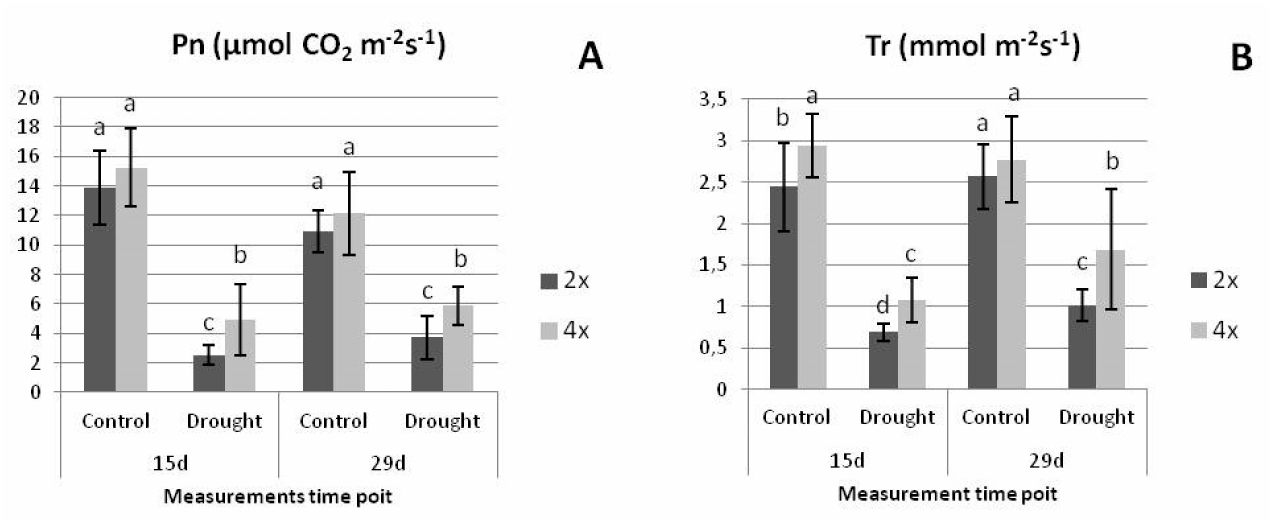
Figure 6. Physiological parameters of diploid (2x) and tetraploid clone 4x-25 of the apple cv. ‘Red- chief’, optimally irrigated and subjected to drought stress, 15 and 29 days after drought induction: ( A ) net photosynthesis rate (Pn) and ( B ) transpiration rate (Tr). Bars marked with the same letter do not differ significantly at p = 0.05; Duncan’s